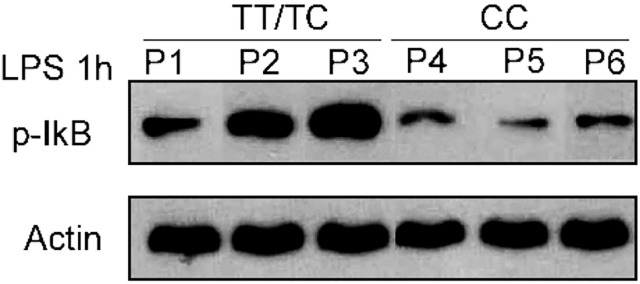
p-IkB expression in PBMCs from AIH-1 patients after LPS stimulation for 1h.P1/P2: patients (n = 2) with TT genotype; P3: patient (n = 1) with TC genotype; P4/P5/P5: patients with CC genotype (n = 3)